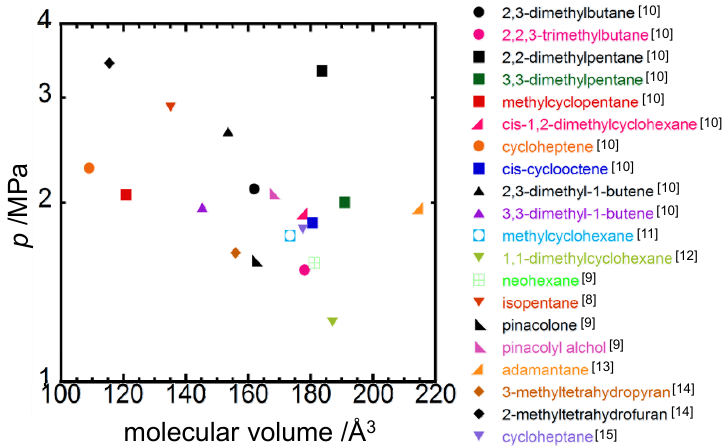
Figure 3. Correlation plot between molecular volume of LMGS and the equilibrium pressure at 276 K.